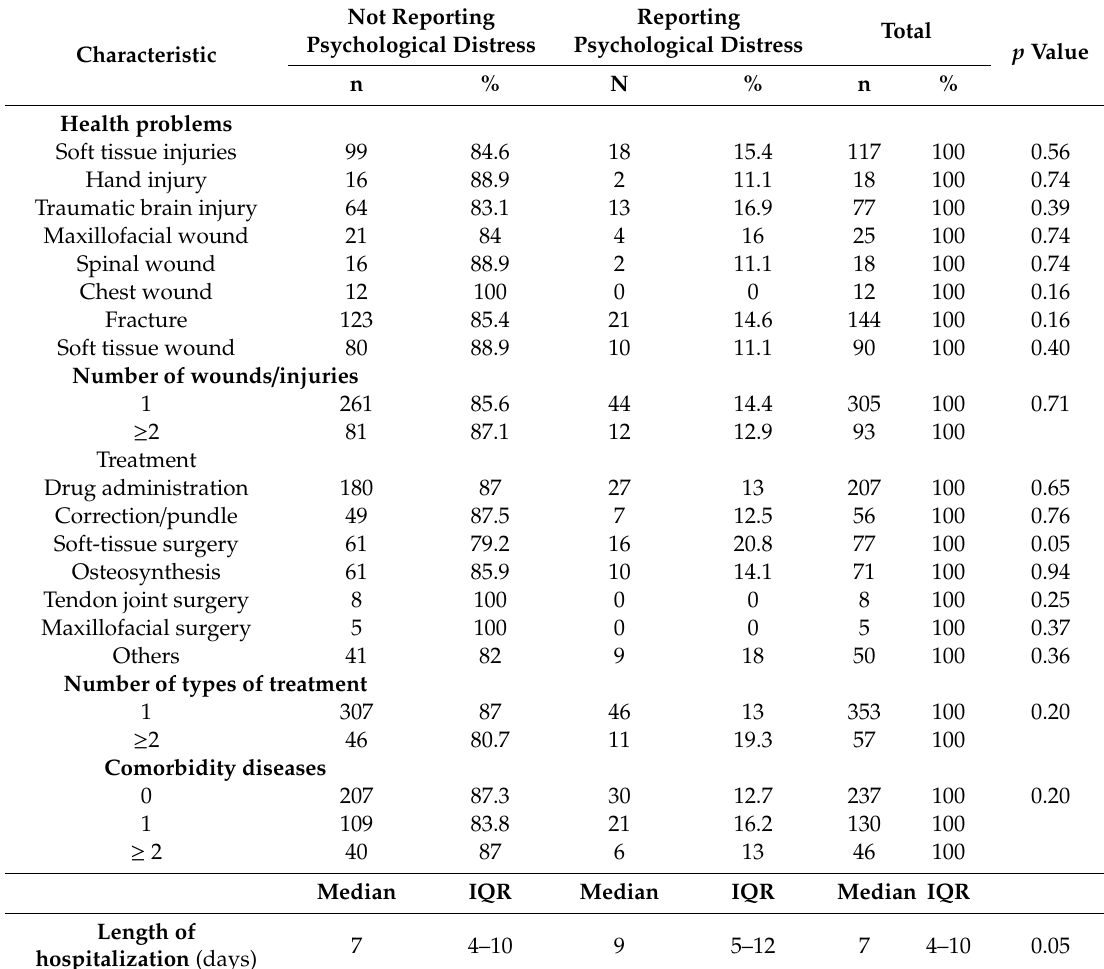
Table 2. Psychological distress according to types of injury and treatment.